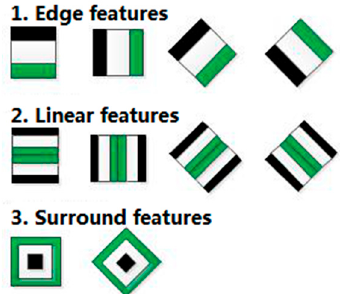
Figure 4. Improved sparse Haar-like feature operators.